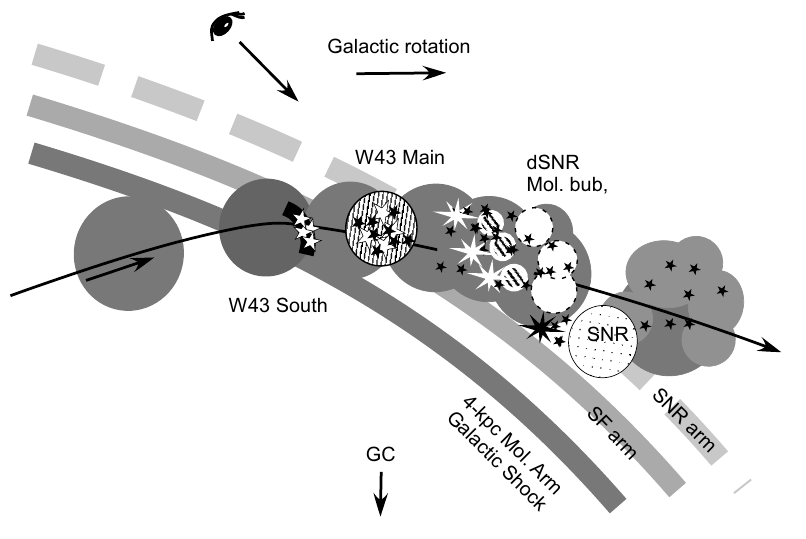
Figure 5. Face-on view of the 4-kpc arm from the north Galactic pole, illustrating the evolution of a molecular cloud and dark supernova remnants (dSNRs) along the Galactic flow line by rotation through a galactic